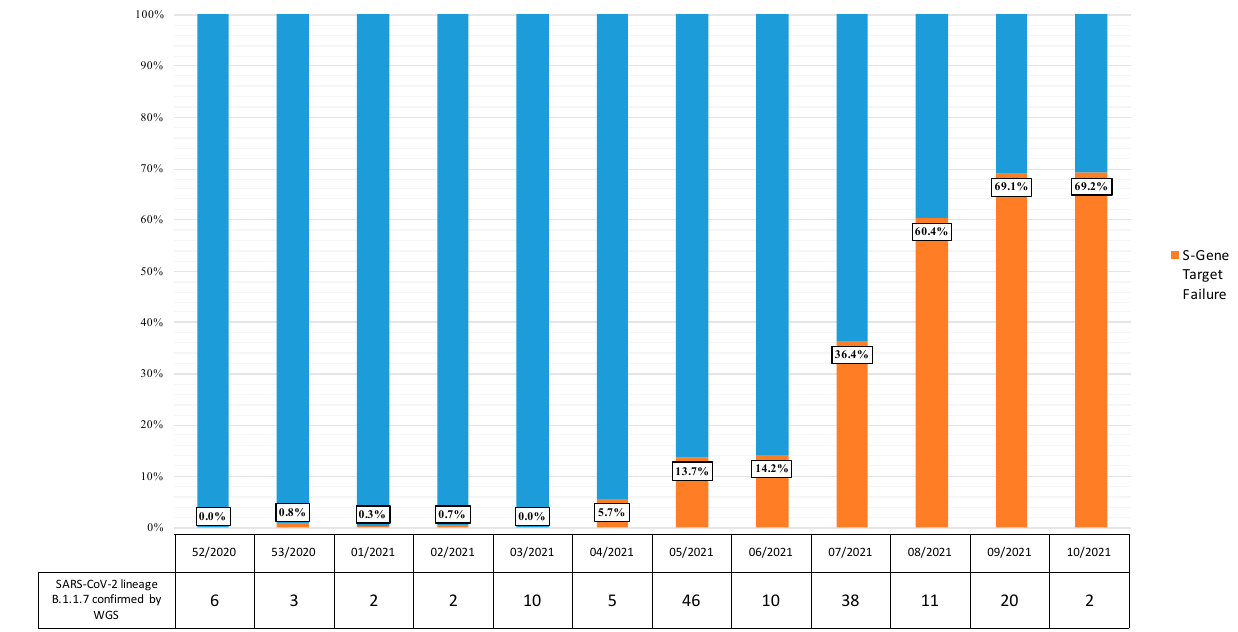
SARS-CoV-2 lineage B.1.1.7 confirmed by WGS